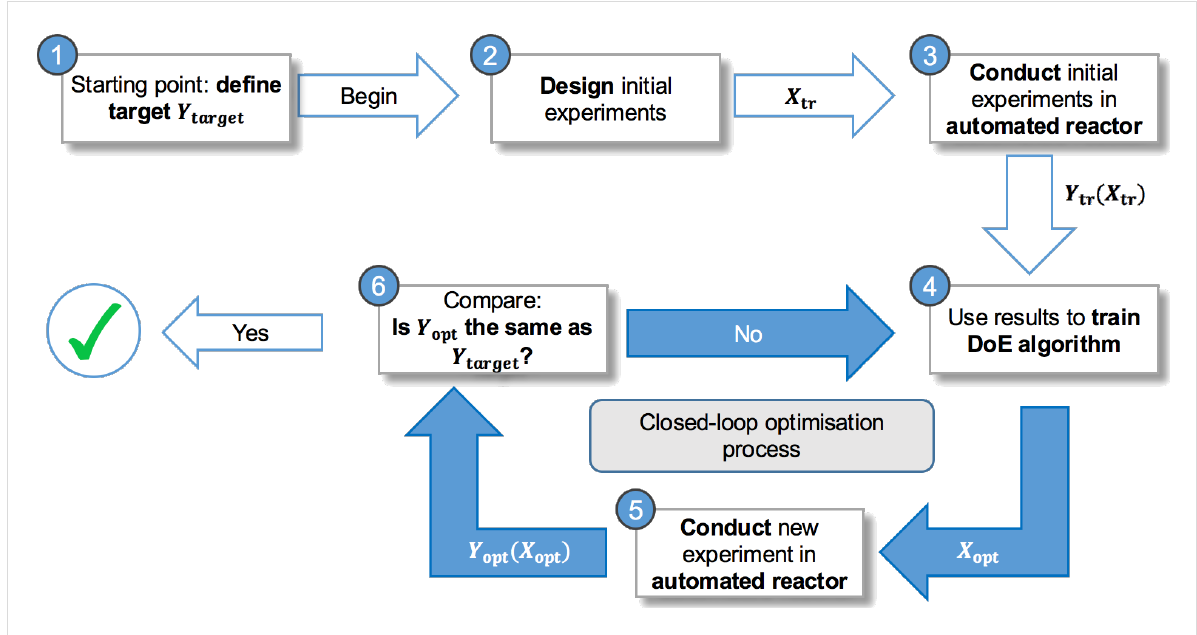
Figure 1: A framework of closed-loop or self-optimisation combining smart DoE algorithms, process analytics, chemoinformatics and automated reactor systems.